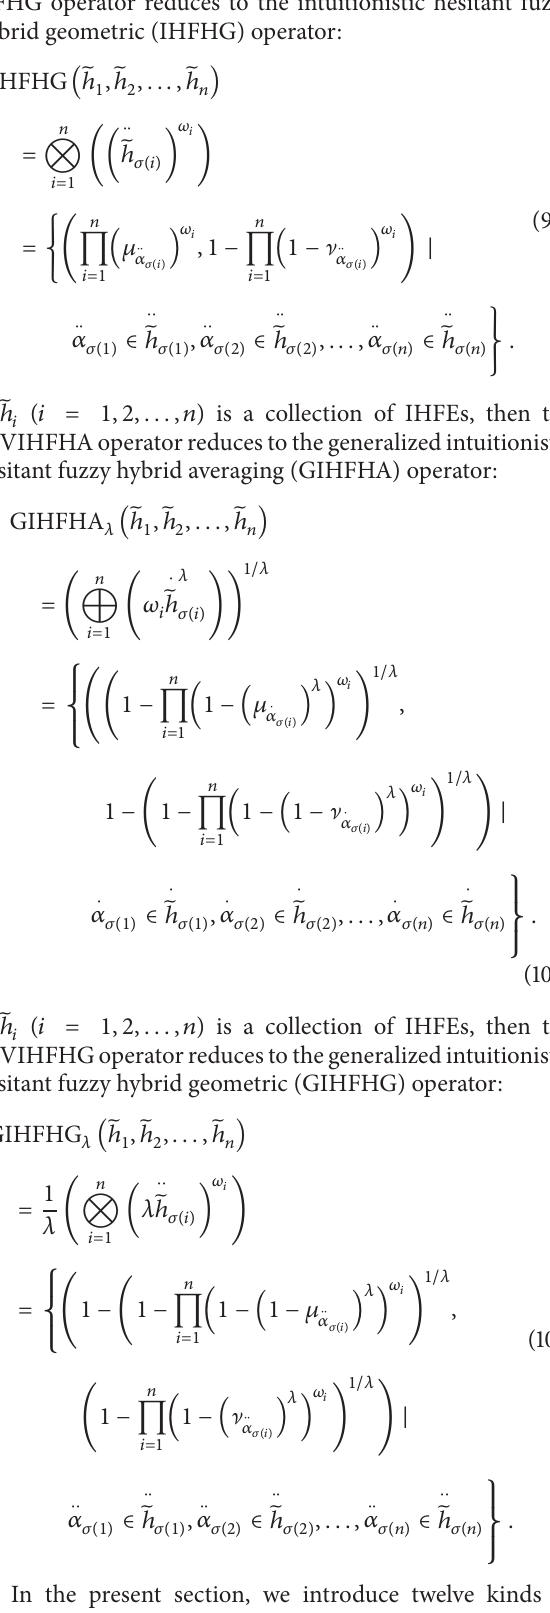
Table 1: Interval-valued intuitionistic hesitant fuzzy aggregation